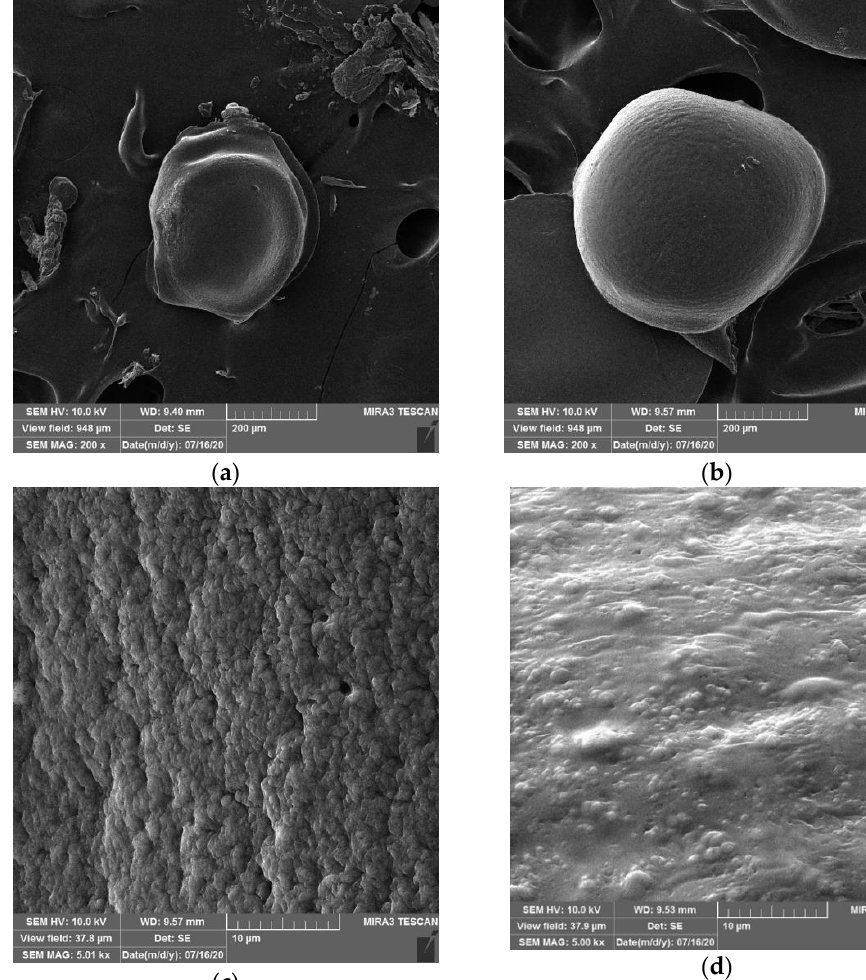
Figure 1. SEM micrographs of ( a ) blank alginate EE microbeads at 200× magnification; ( b ) activated alginate EE microbeads with immobilized alcalase at 200× magnification; ( c ) blank alginate EE microbeads at 5000× magnification; ( d ) activated alginate EE microbeads with immobilized alcalase at 5000× magnification.